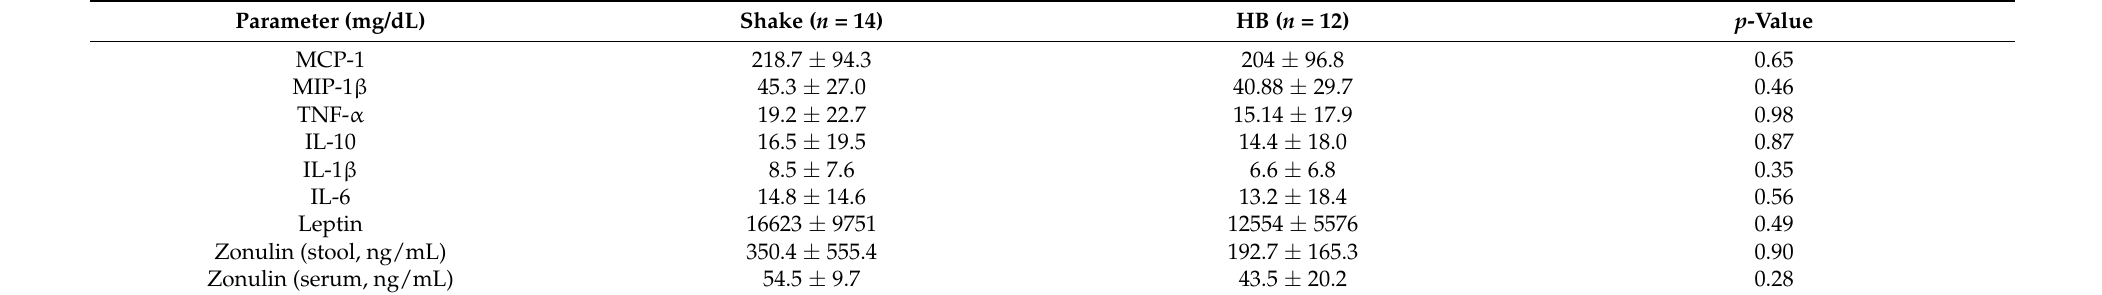
Table 5. Cytokines and leptin for Shake vs. Habitual